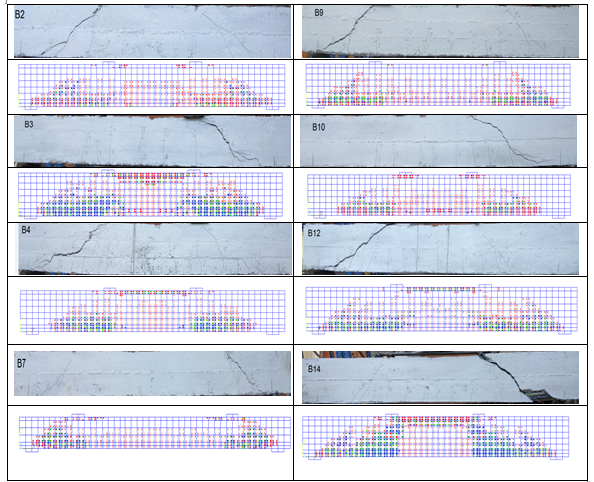
Figure 11: Comparison between crack pattern from (F.E.) and experi- mental test for